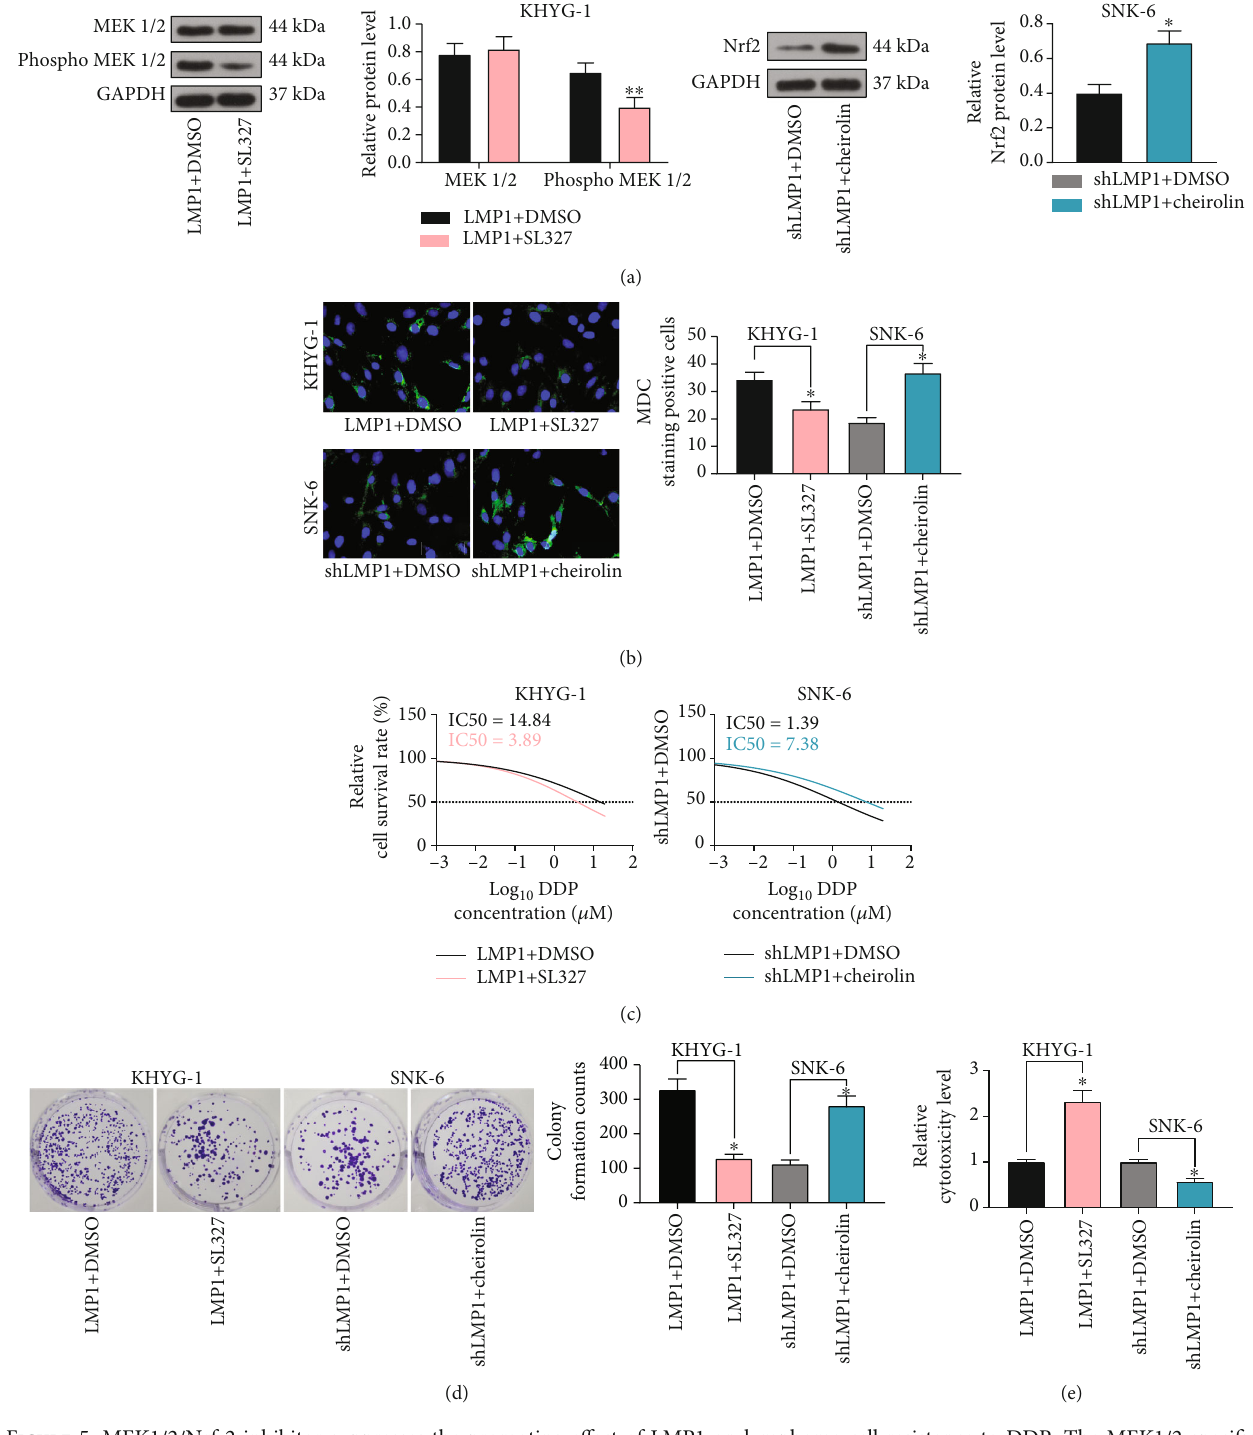
Figure 5: MEK1/2/Nrf-2 inhibitor suppresses the promoting e ff ect of LMP1 on lymphoma cell resistance to DDP. The MEK1/2 speci fi c inhibitor SL327 was added to the KHYG-1 cells overexpressing LMP1, and Nrf-2 speci fi c activator cheirolin was added to the SNK-6 cells poorly expressing LMP1. (a) The extent of MEK1/2 phosphorylation in the KHYG-1 cells and the expression of Nrf-2 in the SNK-6 cells were detected by western blot analysis. (b) The autophagy level was observed by MDC staining. (c) The IC50 value of KHYG-1 and SNK- 6 cells to DDP measured by CCK-8 assay. (d) Cell proliferation was detected by colony formation assay. (e) The cytotoxicity of DDP to the KHYG-1 and SNK-6 cells tested by LDH kit. All data are displayed in the form of mean ± standard deviation . (b, d, and e) One-way ANOVA and Tukey ’ s multiple comparison test are used to test the signi fi cant di ff erence of data. (a and c) Two-way ANOVA and Tukey ’ s multiple comparison test are used to test the signi fi cant di ff erence of data. ∗ p < 0 : 05 . ∗∗ p < 0 : 01